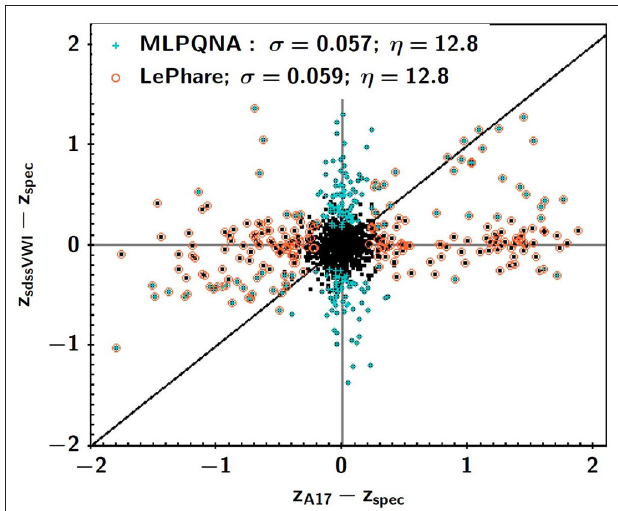
FIGURE 7 | Figure from Brescia et al. (2019). Difference between spectroscopic redshift and photo-z computed via the MLPQNA neural network and the SED fitting method, LePhare, for the subsample including the complete photometry available (SDSS, VHS, WISE, and IRAC), regardless of their X-ray flux. Sources that are outliers for MLPQNA (LePhare) are plotted in cyan (orange). For this subsample, the two methods have a similar performance behavior. Nevertheless, the majority of the outliers are such only for one of the two algorithms. For the common outliers along the black one-to-one line, the two methods agree in terms of predicted